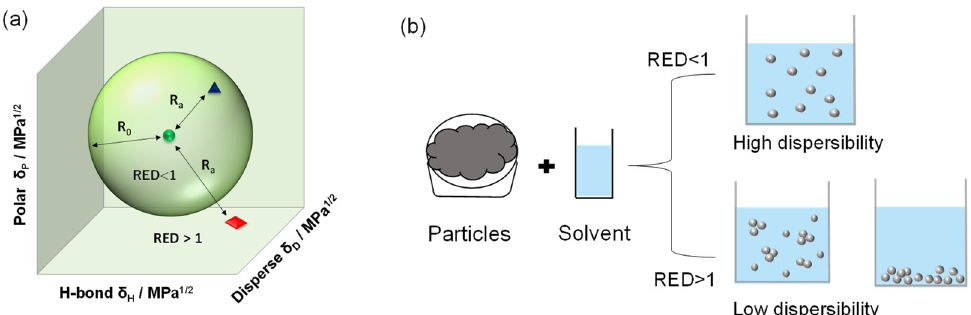
Figure 1. ( a ) The Hansen solubility sphere. The blue triangle indicates high solubility of the solute in the solvent, while the red square indicates low solubility; ( b ) particle dispersibility in solvents. An RED value of <1.0 shows that the particles are evenly distributed throughout the solvent (“High dispersibility”), while an RED value of >1.0 shows particle clumping or settling (“Low dispersibil-